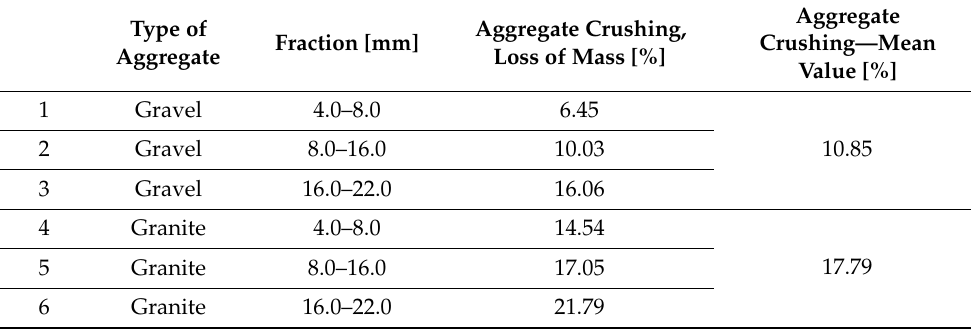
Table 2. The crushing values for gravel and granite aggregate.